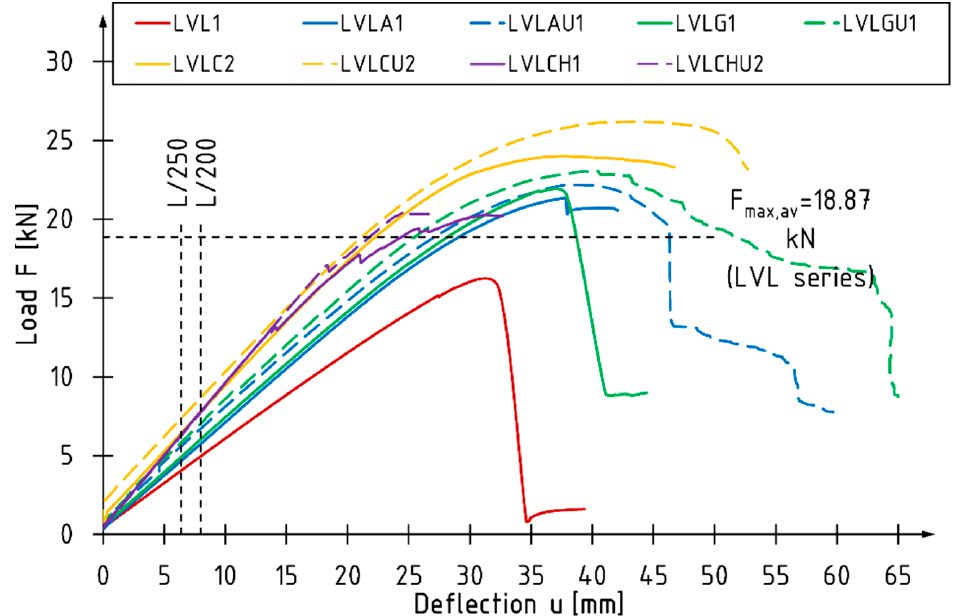
Figure 6. Force versus deflection curves for selected beams.